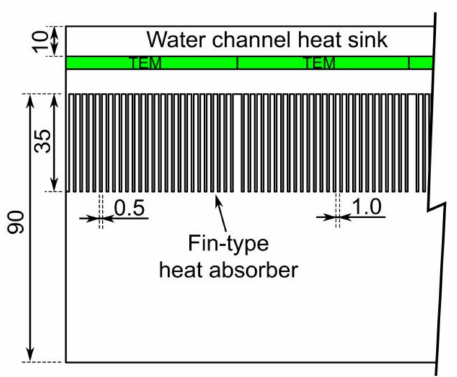
Figure 1. Cross-sectional view of the ATEG model (dimensions in